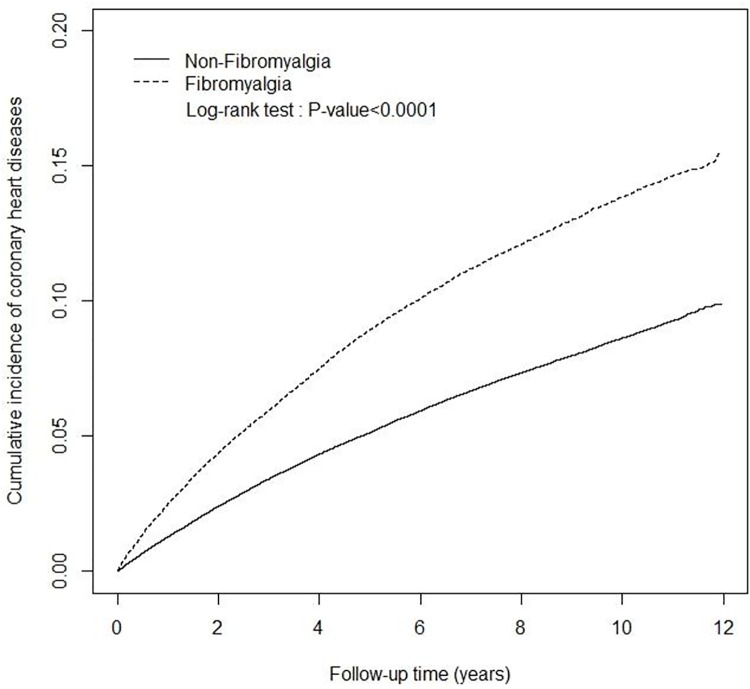
Cumulative incidence of coronary heart diseases between the fibromyalgia cohort (dashed line) and non-fibromyalgia cohort (solid line).